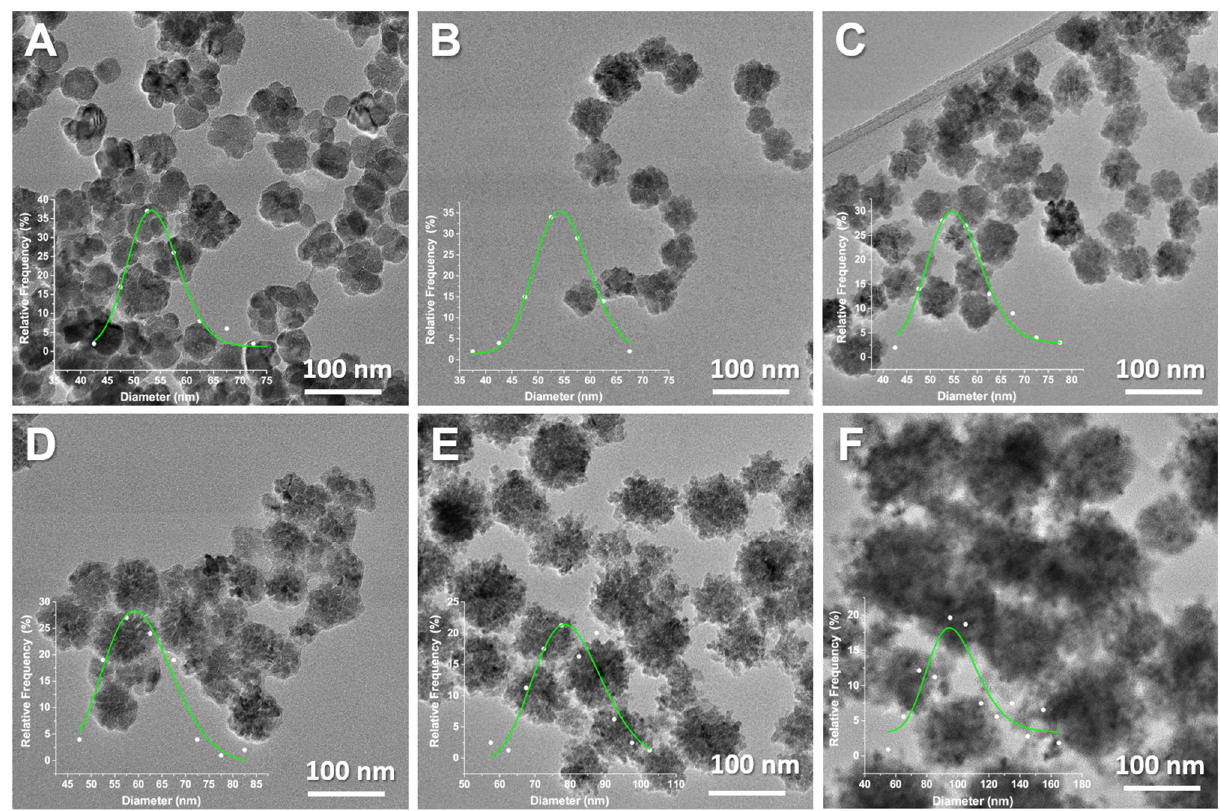
Figure 2. TEM images of γ -Fe 2- x Y x O 3 ( A ) x = 0; ( B ) x = 0.005; ( C ) x = 0.011; ( D ) x = 0.014; ( E ) x = 0.028 and ( F ) x = 0.031. Corresponding particles’ size distribution has been given as figure insets. As stated, all nanoconstructs have a flower morphology, which indicates that the in- corporation of yttrium into the maghemite structure does not affect the formation of nanoflowers. However, we should keep in mind that the limit concentration of yttrium in γ -Fe 2- x Y x O 3 is low ( x around 0.03). The reaction yield for the last sample in the series was